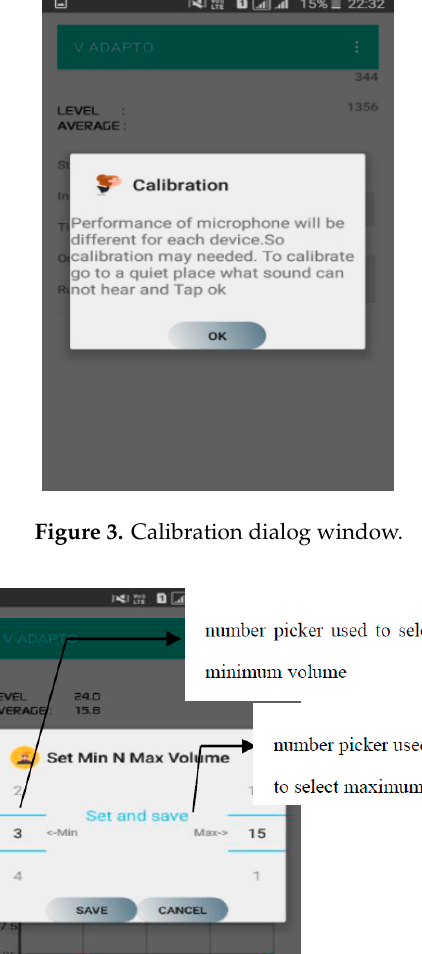
Figure 5. Start time and end time. ( a ) Start time ( b ) Stop time. The activity-recognition algorithm identifies the current activity of the user. The activities can be classified into simple and complex activities. Activities such as walking, walking on stairs, jogging, jumping, driving a motorcycle, driving a car or holding a mobile in hand and placing the mobile on table are known as simple activities. Commonly used sensors in mobile phones are accelerometer [25,26], gyroscope [27], magnetometer [28,29], proximity sensor, light sensor [30], barometer [31,32], thermometer, air humidity sensor [33,34], etc. The user activity can be recognized with the help of these sensors. Accelerometer sensor measures the acceleration in any axis. However, by moving the device in any axis, the sensor data will spike. The device's orientation along its three-axis can be sensed by the gyroscope sensor [35]. The acceleration can be measured along three spatial axis at any time instant as